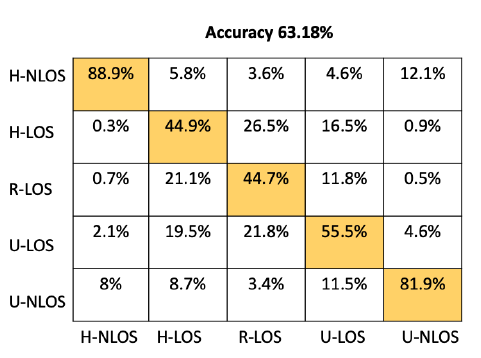
Figure 6. Confusion matrix for ANN based on LTS approach.